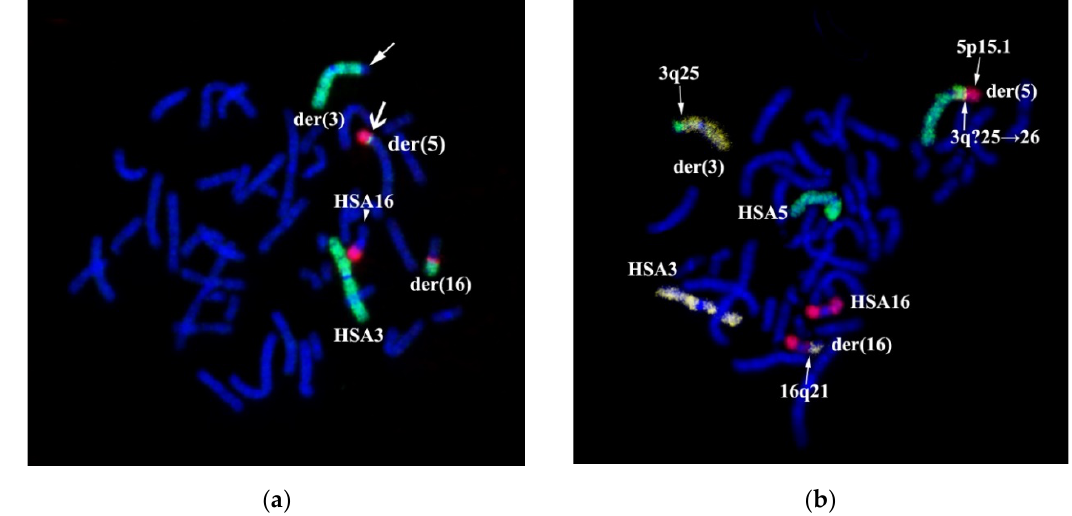
Figure 6. Two-color WCP3(green) / PCP16q(red) ( a ) and three-color WCP3(yellow) / WCP5(green) / WCP16(red) ( b ) CISS-hybridization on the patient’s metaphase chromosomes. ( a ) (cid:212) —arrow indicates WCP3 (green) signal at the short arm of chromosome 5 derivative. (cid:221) —arrow indicates the absence of a signal at the long arm of chromosome 3 derivative. Three-color CISS hybridization WCP3(green) / WCP5(green) / WCP16(red) ( b ) on metaphase chromosomes of the patient. Chromosomes and chromosomal regions with specific signals are indicated. ( b ) (cid:221) —arrow indicates breaking points in 3q25; 16q21; 5p15.1 loci. Further, 3q?25 → 26 is a chromosome 3 segment detected by fluorescent in situ hybridization (FISH) in the short arm of chromosome 5 derivative. CISS hybridization revealed a region from chromosome 3 in der(5). Chromatin DAPI staining is in blue.